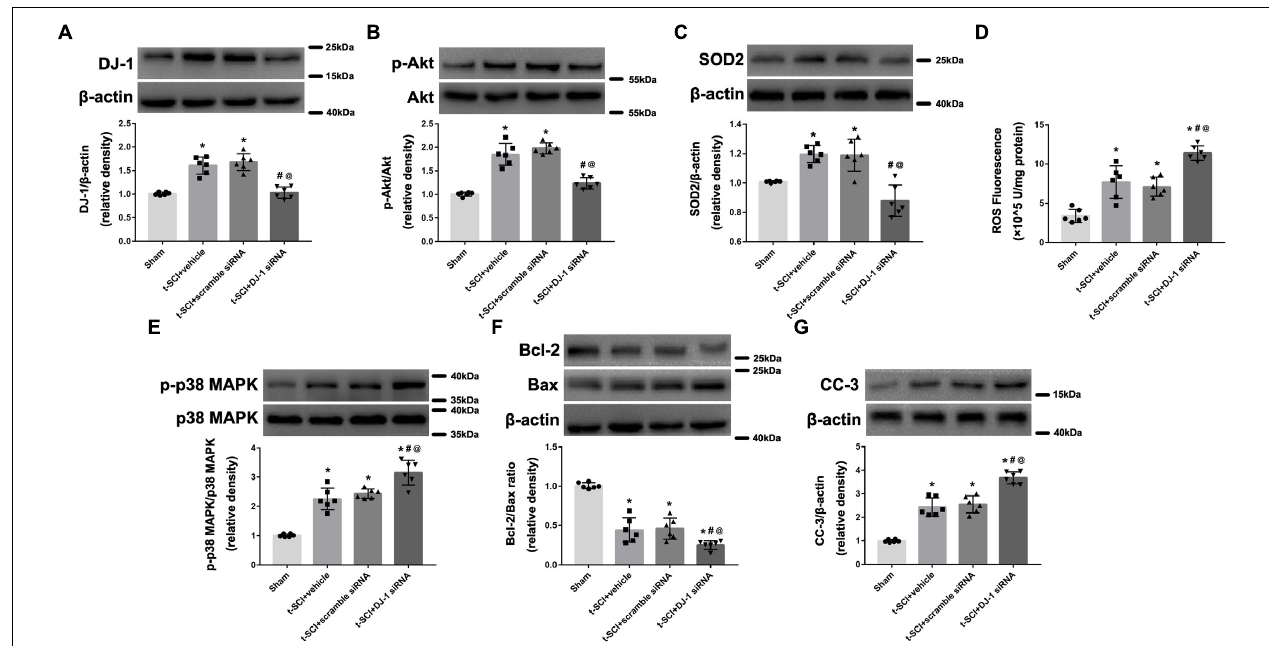
FIGURE 4 | Representative Western blots showing the protein levels in each group at 24 h post-injury. The expression levels of DJ-1, p-Akt, and SOD2 were significantly increased after t-SCI, treatment with DJ-1 siRNA significantly decreased the levels of DJ-1, p-Akt, and SOD2 (A–C) . The ROS level, p-p38 MAPK/p38 MAPK ratio, and CC-3 level was significantly elevated, whereas the Bcl-2/Bax ratio was significantly reduced after t-SCI, and treatment with DJ-1 siRNA significantly aggravated these effects (D–G) . Injection of scramble siRNA did not change the expression levels of DJ-1 and the downstream targets (A–G) . N = 6 for each group. Data is expressed as mean ± SD and analyzed by one-way ANOVA and Bonferroni’s post hoc multiple comparisons test. ∗ p < 0.05 versus sham; # p < 0.05 versus t-SCI + vehicle; @ p < 0.05 versus t-SCI + scramble siRNA.